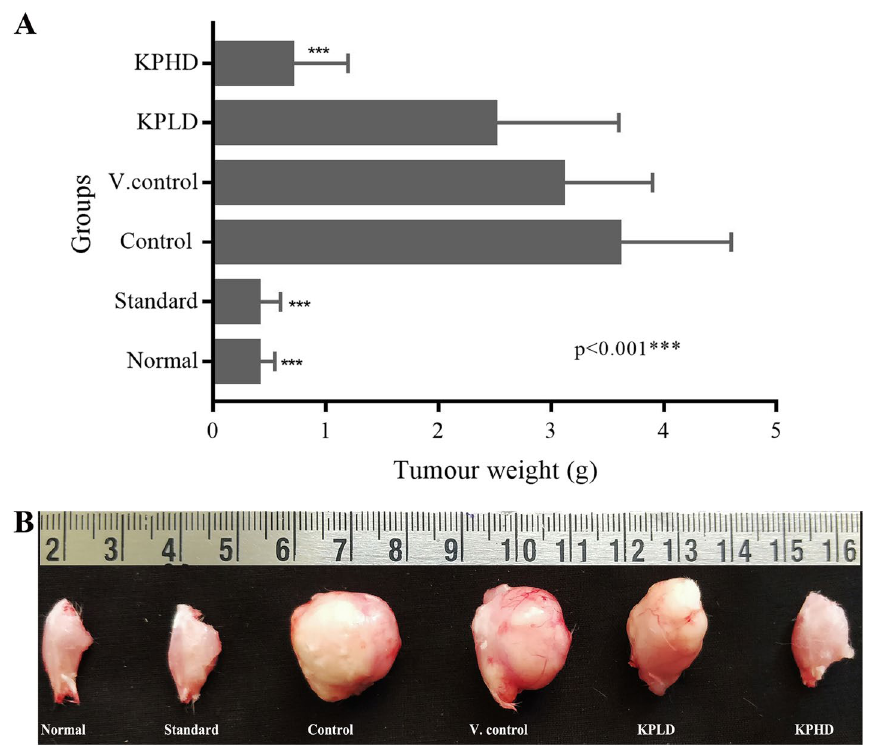
Fig. 4 Effect of K. pinnatum extract on DLA induced mouse solid tumor. Results are presented as mean determine the statistical comparison followed by Dunnett’s multiple comparison test. * P < 0.05, ** P < 0.01, *** P < 0.001, statistically significant as compared to the control